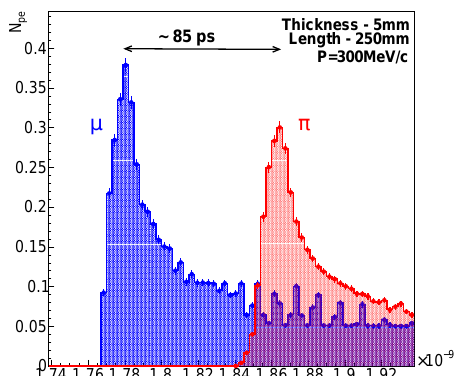
Figure 8. The “ToF + TOP” approach scheme. Figure 9. Time distribution of detected Cherenkov photons generated by muon (blue) and pion (red) in quarts bar (5 × 5 mm 2 cross-section) at the distance 250 mm from